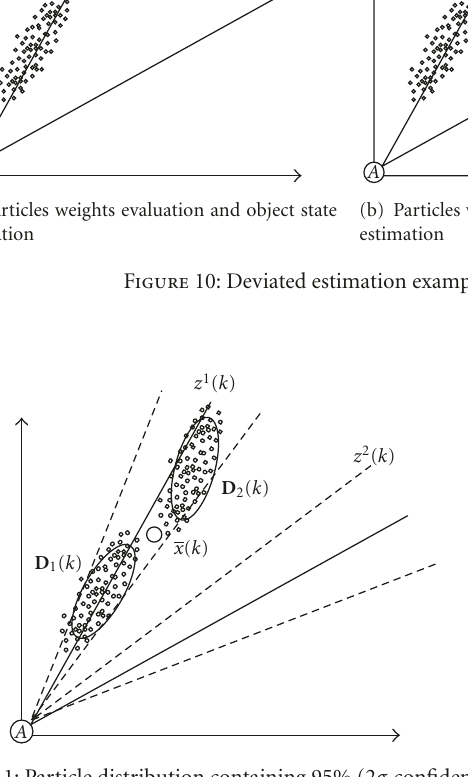
Figure 11: Particle distribution containing 95% (2 σ confidence) of the particles assuming they are Gaussian